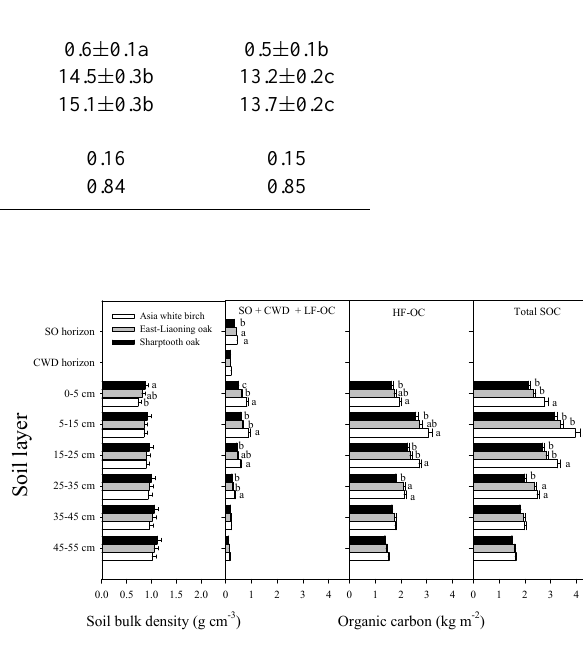
Fig. 2. Vertical distribution of soil bulk density, light fraction or- ganic carbon (LF-OC), heavy fraction organic carbon (HF-OC) and total soil organic carbon (SOC), and carbon of coarse woody debris (CWD) and surface organic (SO) horizon in Asia white birch and East-Liaoning oak forests of warm temperate zone and Sharptooth oak forest of sub-topical zone. Horizontal bars indicate standard er- rors of means ( n =5). Different letters within a soil layer are signif- icantly different ( P < 0.05) according to the least significant differ- ence test. Absence of letters implies that no significant differences were